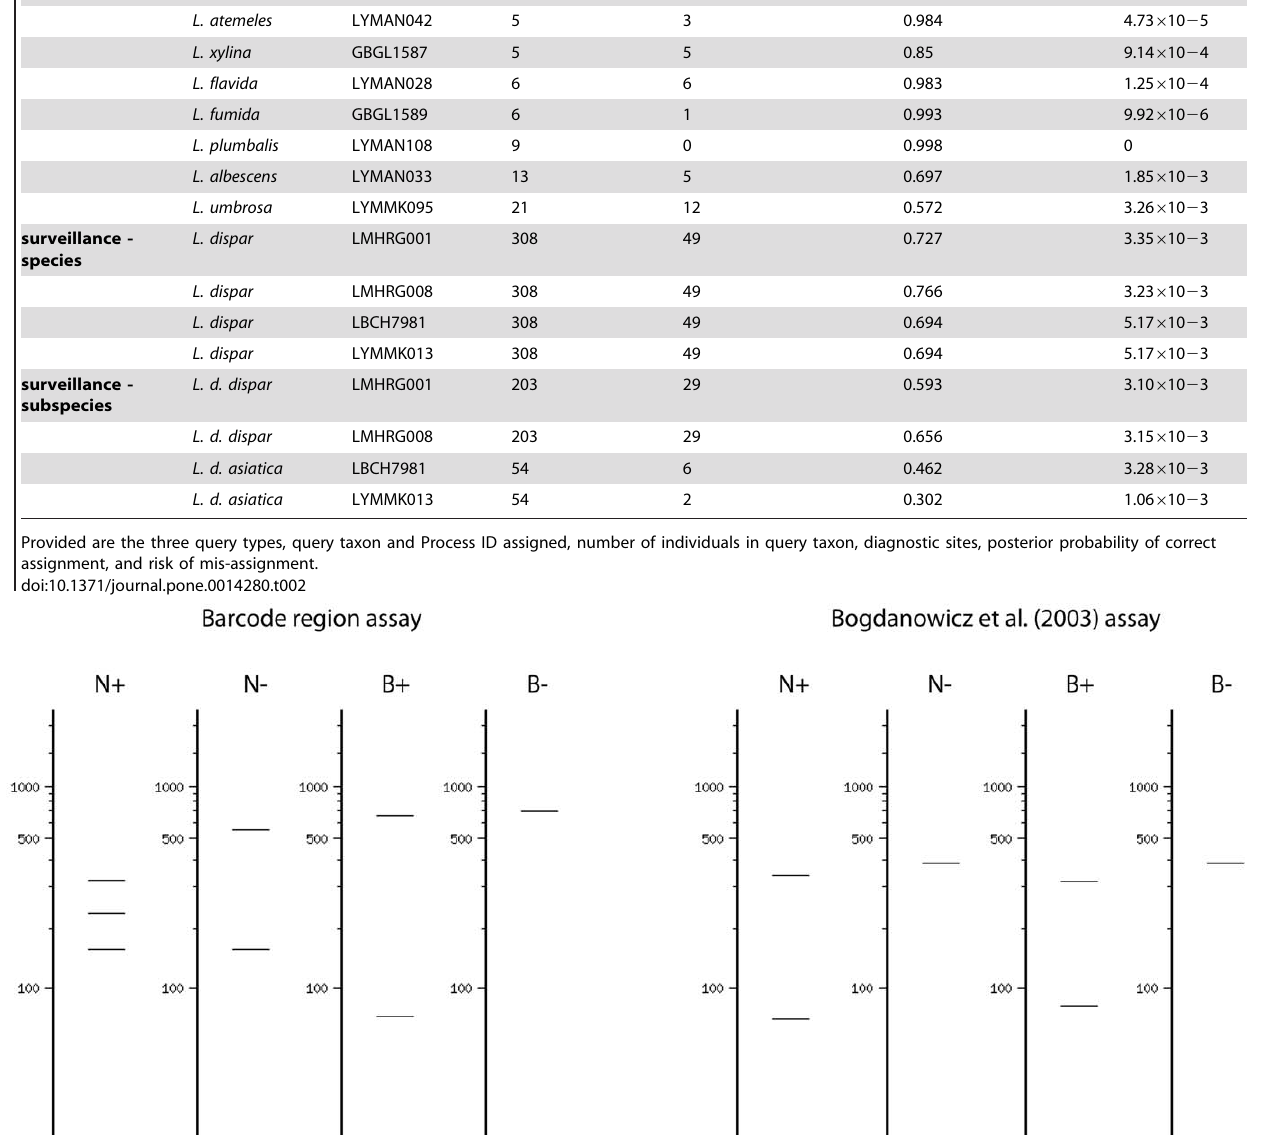
Query Query taxon Process ID No. of individuals No. of diagnostic sites species